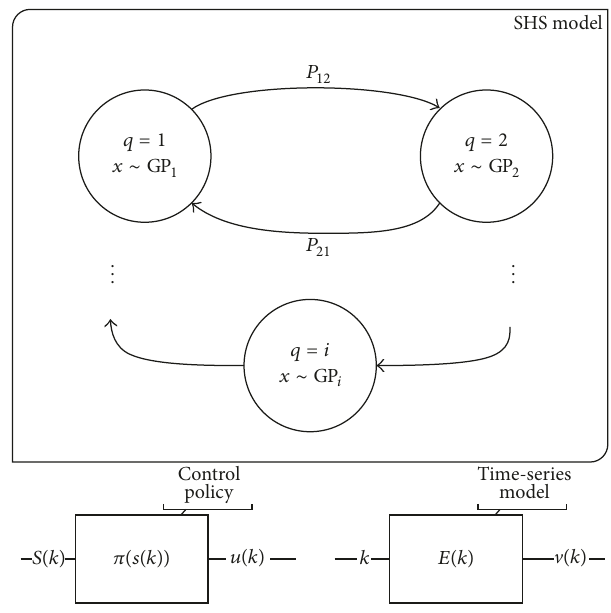
Figure 1: Nonparametric SHS components and